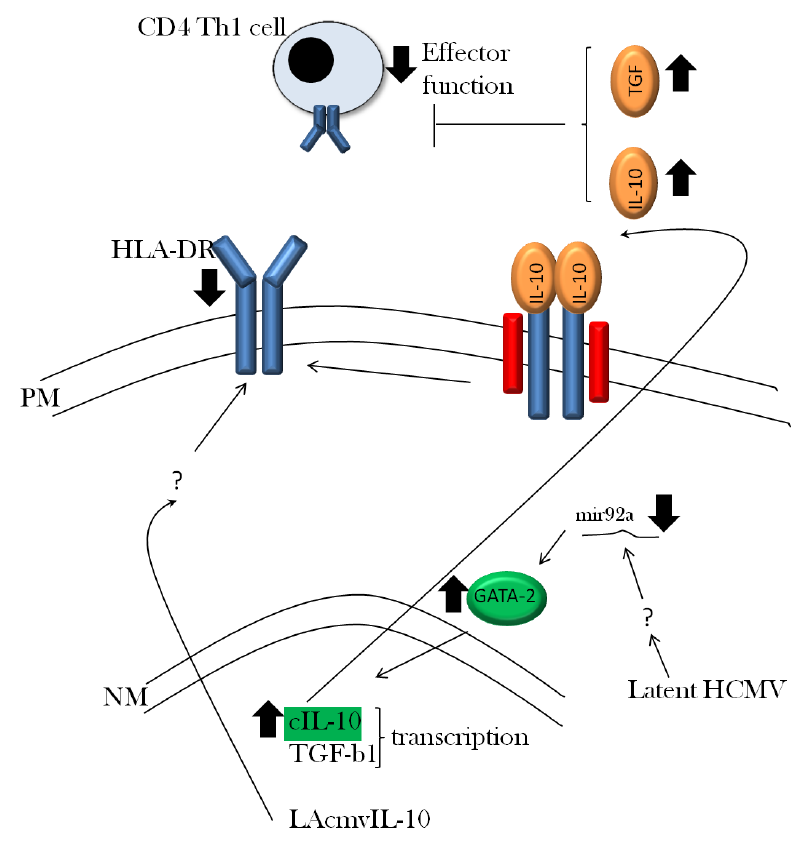
Figure 2. Evasion of the immune response to HCMV. The up-regulation of IL-10 in latently infected CD34+ cells is concomitant with TGF-b up-regulation via an unknown mechanism. However, the expression of two potent immune-suppressive cytokines inhibits the effector functions of CD4 Th1 cells recruited to a latently infected cell. Furthermore, both cellular IL-10 and viral IL-10 (LAcmvIL-10) act in concert to promote the down-regulation of HLA-DR MHC class II molecules on the surface of latently infected cells. Although the mechanism used by LAcmvIl-10 is not yet understood but is known not to occur via binding to the cellular IL-10